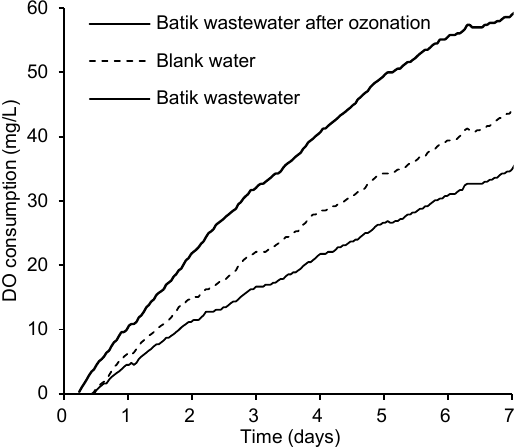
Figure 9. DO consumption by activated-sludge microorganisms at 25 °C in high-strength synthetic batik wastewater containing 96 mg/L RB5 and 96 mg/L RO16 before and after 30 min ozonation. As shown in Figure 10, the TOC concentration in the high-strength wastewater was reduced from 52.6 mg/L to 39.6 mg/L after 14 days of biodegradation alone, 50.3 mg/L after 30 min ozonation alone, and 17.6 mg/L after 30 min ozonation followed by 14 days of biodegradation. The BOD 5 /TOC ratio of the high-strength synthetic batik wastewater after 30 min ozonation was 0.31.